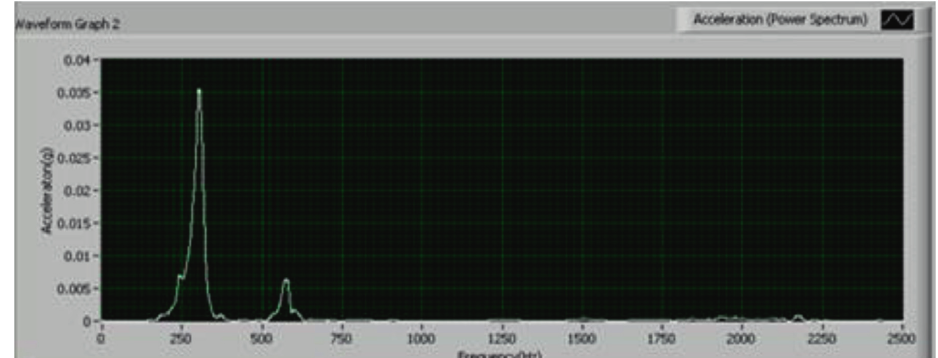
Figure 10: Frequency response of A3 steel swivel plate under loading condition (4kg).